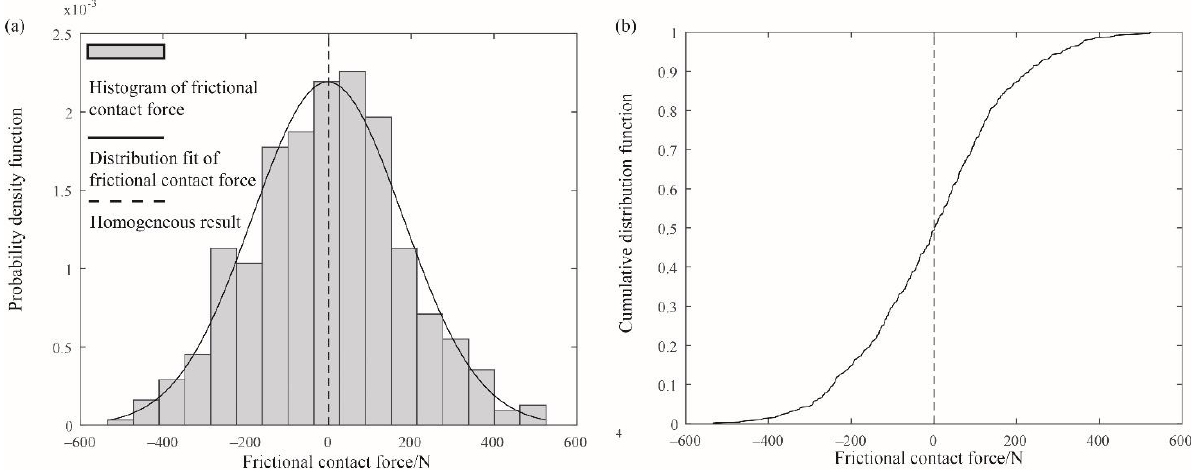
Figure 11. PDF ( a ) and CDF ( b ) of the frictional contact force at the middle bottom point A of the elastic block from 500 realisations when the coefficient of friction is 0.3.